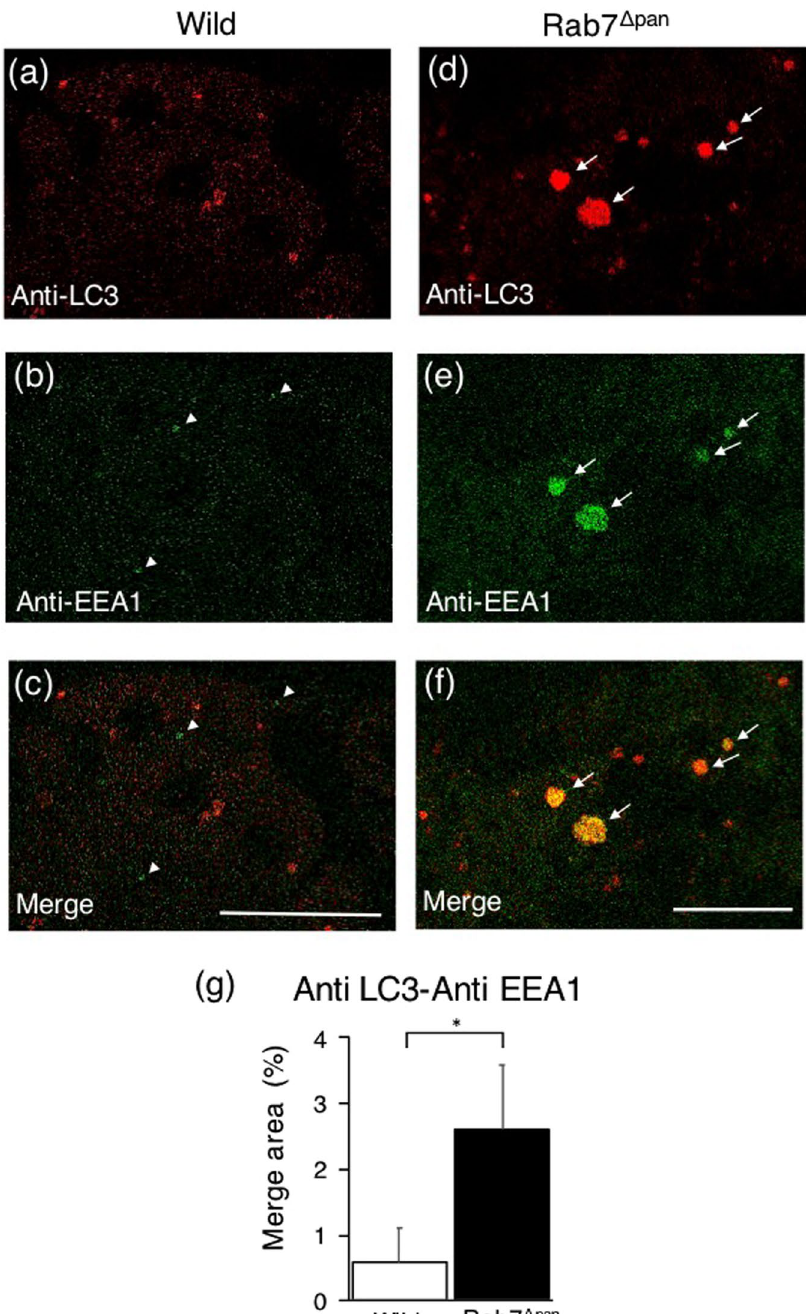
Figure 11. Immunofluorescence images of pancreatic acinar cells with caerulein-induced acute pancreatitis double-stained with anti-LC3 and anti-EEA1 antibodies. The EEA1 signals were small but discernible in wild pancreatic acinar cells (arrowheads). In Rab7 Δ pan pancreatic acinar cells, the EEA1 signals are highly colocalized with LC3 signals (arrows). Scale Bars: 10 µ m. ( g ) Quantification of the merged signals of LC3 and EEA1 (yellow signals) in immunofluorescence images. P * <